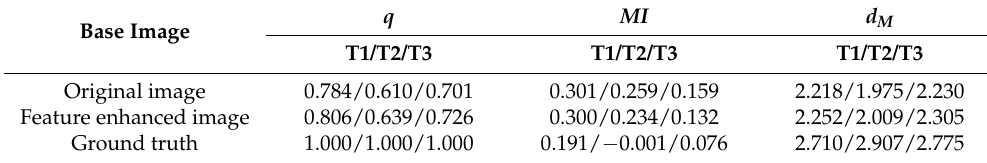
Table 4. Values of the evaluation metric on the reference segmentation results of T1, T2 and